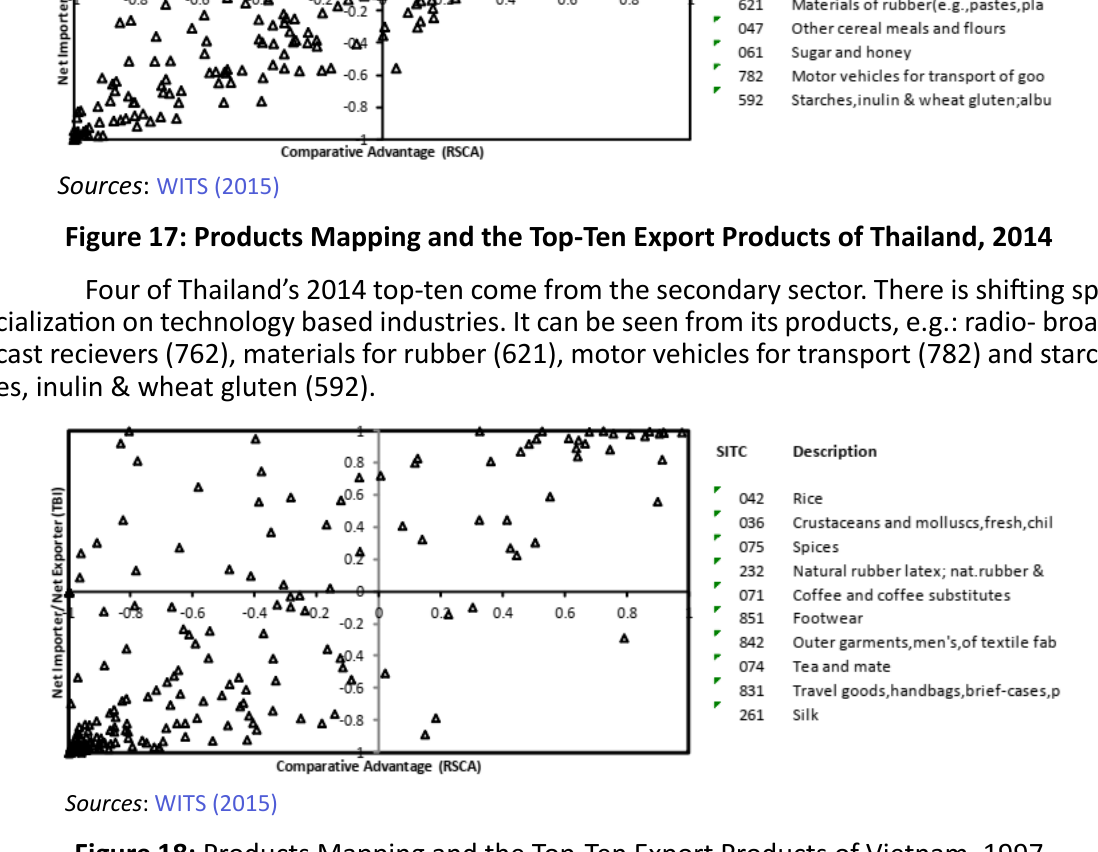
Figure 18: Products Mapping and the Top-Ten Export Products of Vietnam,